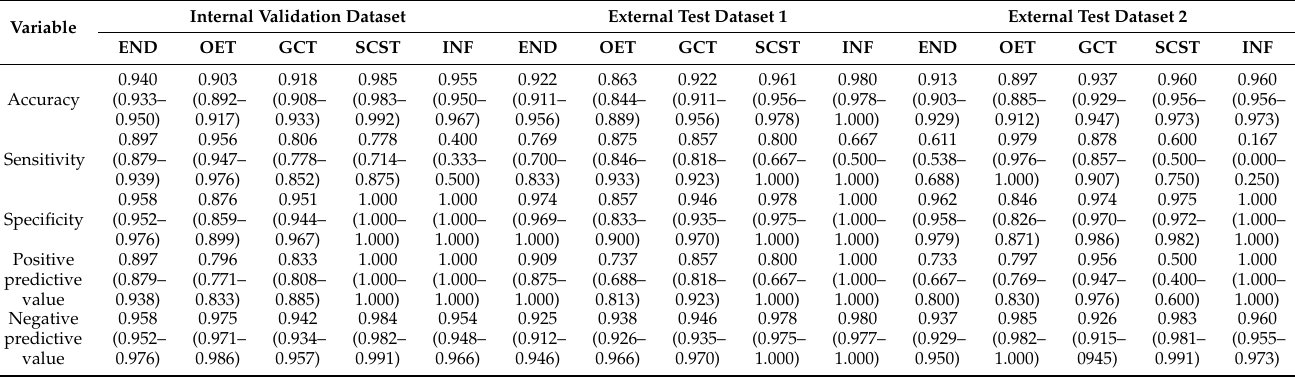
Table 3. Diagnostic performance parameters for the pathological subtype classifier.